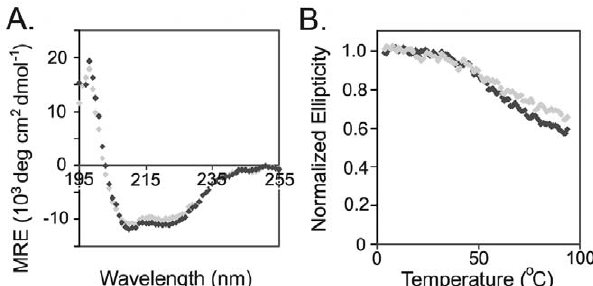
Figure 4. CD spectra of purified WT AcrB and AcrB P223G . A. Wavelength scans at the far UV region of WT AcrB (black) and AcrB P223G (grey) superimposed well onto each other, indicating that the two proteins had similar secondary structure contents. B. Temperature denaturation curves of WT AcrB (black) and AcrB P223G (grey). The ellipticity values monitored at 222 nm were normalized to the reading